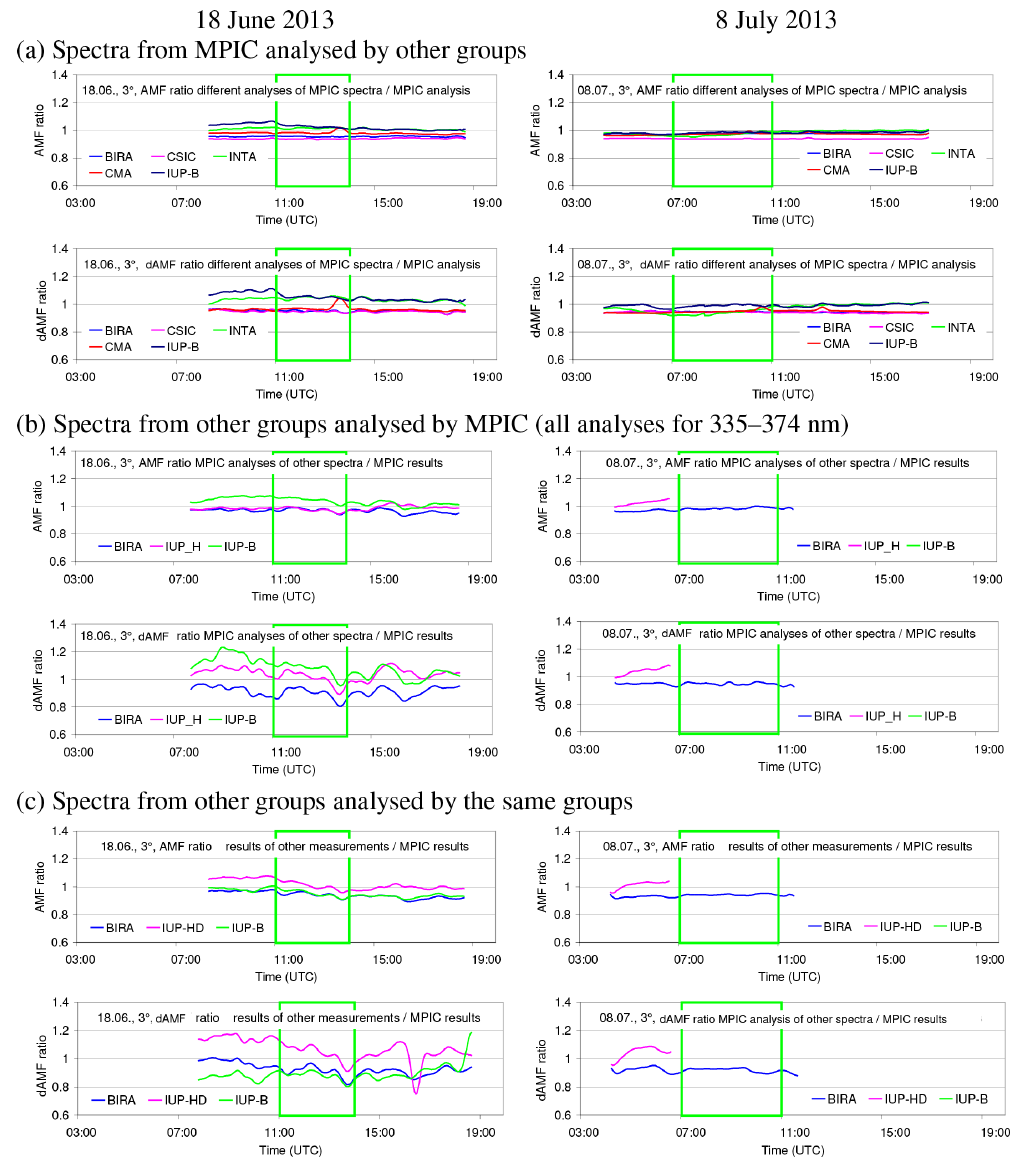
Figure 14. (a) Ratios of the O 4 (d)AMFs derived from MPIC spectra when analysed by other groups vs. those analysed by MPIC for both selected days. (b) Ratios of the O 4 (d)AMFs derived from spectra measured by other groups but analysed by MPIC vs. those for the MPIC instrument analysed by MPIC (using the spectral range 335–374nm for all instruments). (c) Ratios of the O 4 (d)AMFs derived from spectra measured and analysed by other groups (using different wavelength ranges and settings) vs. those for the MPIC instrument analysed by